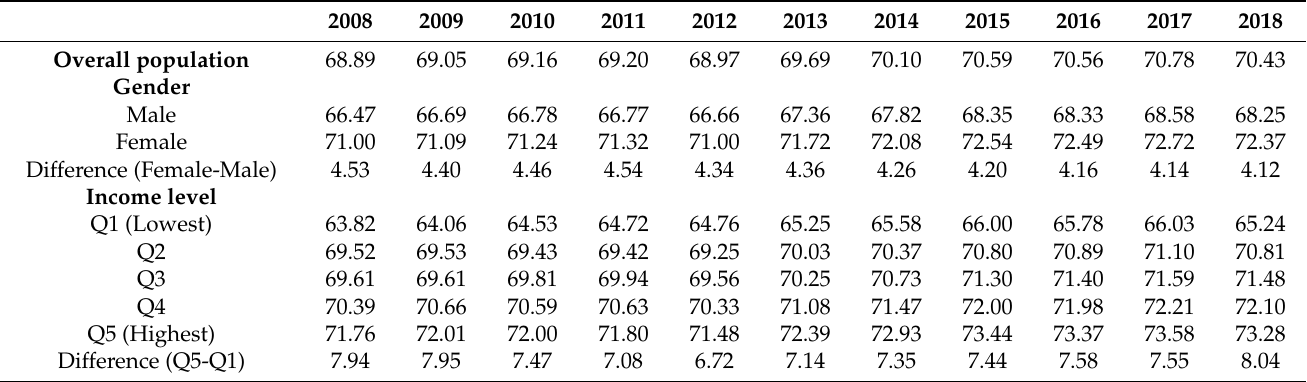
Table 1. Annual health-adjusted life years (HALE) (unit: years) by gender and income level in Korea (2008–2018).